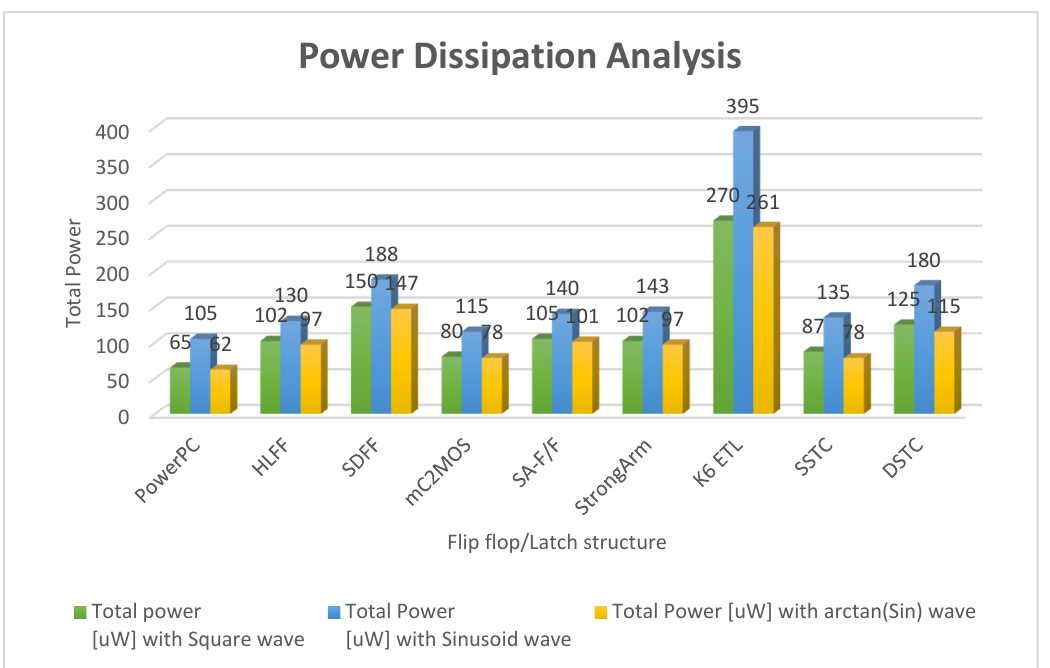
Figure 18. Total power dissipation analysis using 65 nm process technology and various types of input signals.